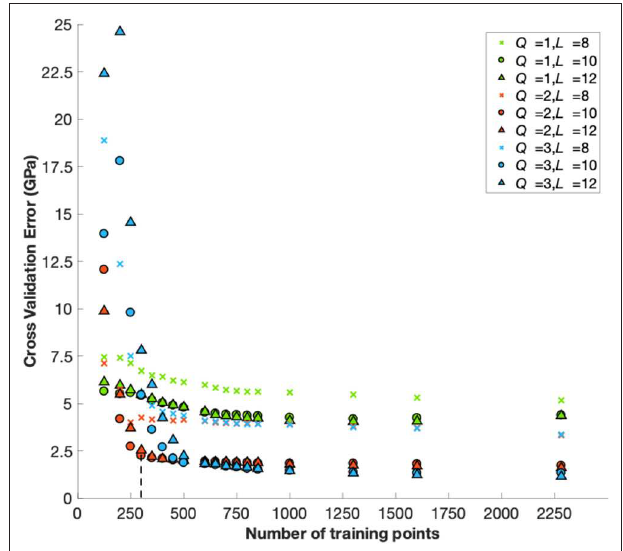
FIGURE 1 | Cross validation error of the reduced-order model built in the first step of the two-step protocol for different truncation levels in Equation (1). The dashed line indicates 300 training